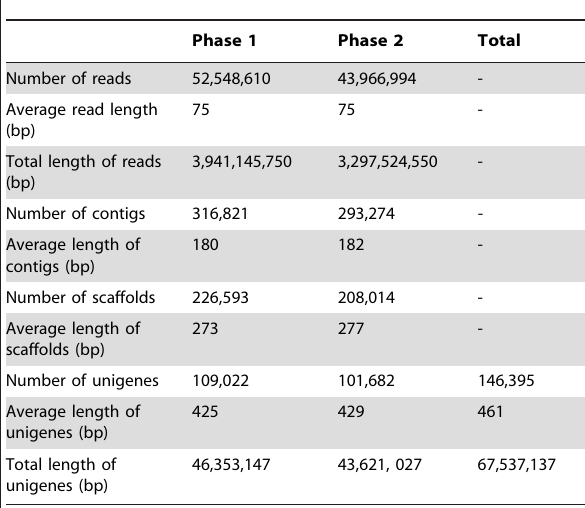
Table 1. Statistical summary of cDNA sequences of